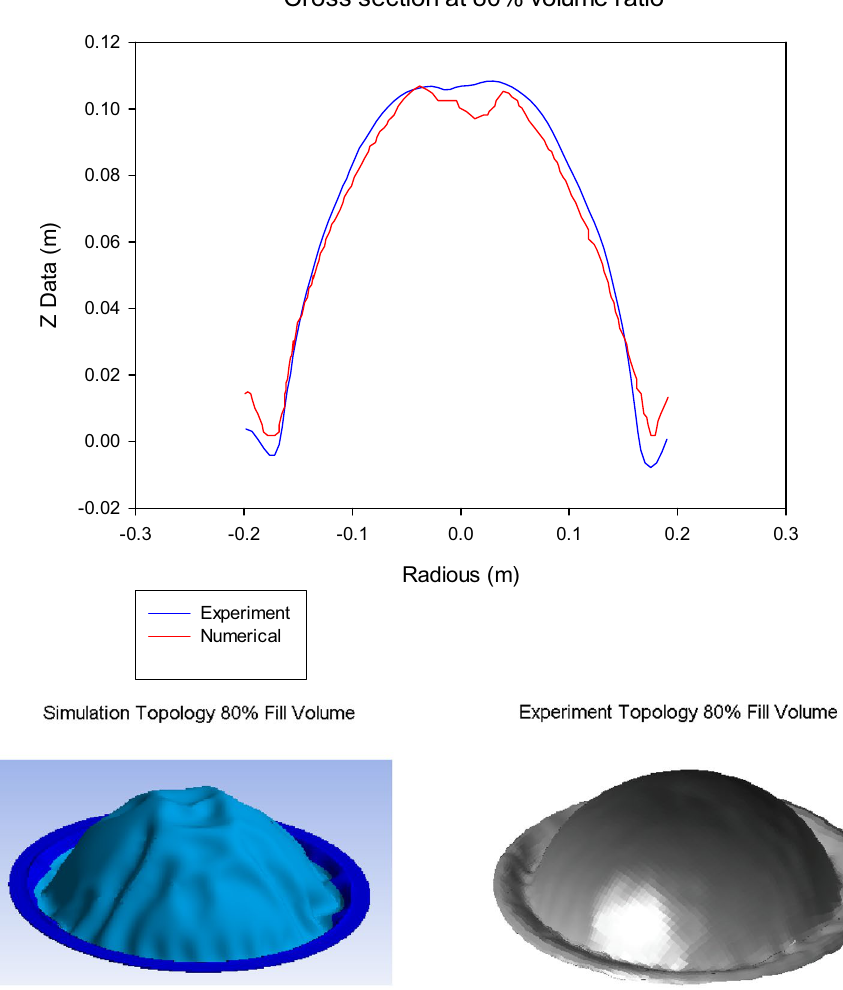
Cross section at 80% volume